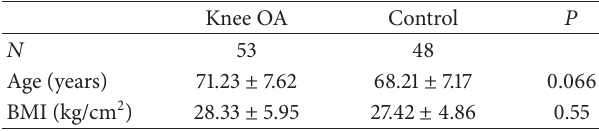
Table 1: Comparison of age and BMI (body mass index) between the knee osteoarthritis (OA) and healthy control